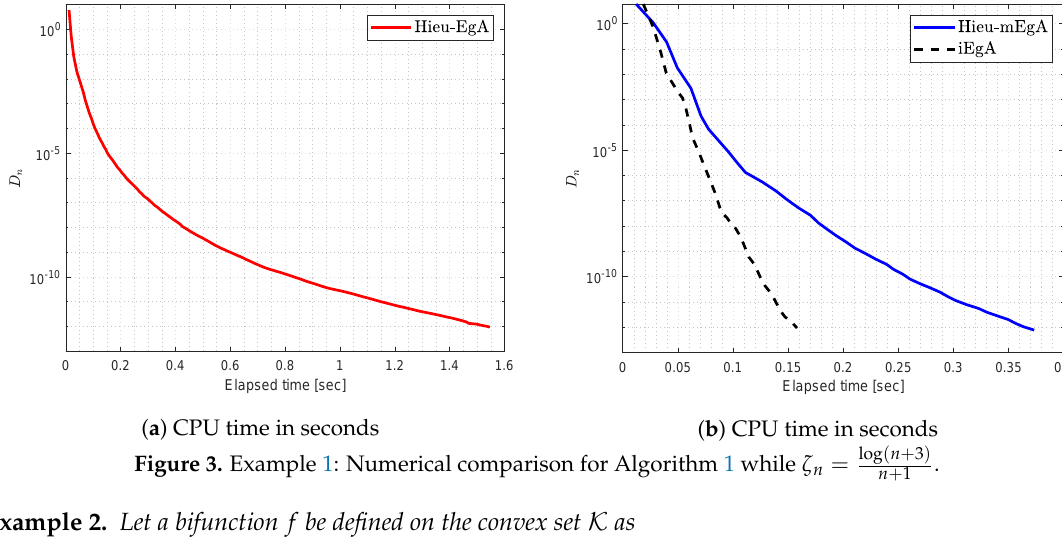
Figure 3. Example 1: Numerical comparison for Algorithm 1 while ζ n = log